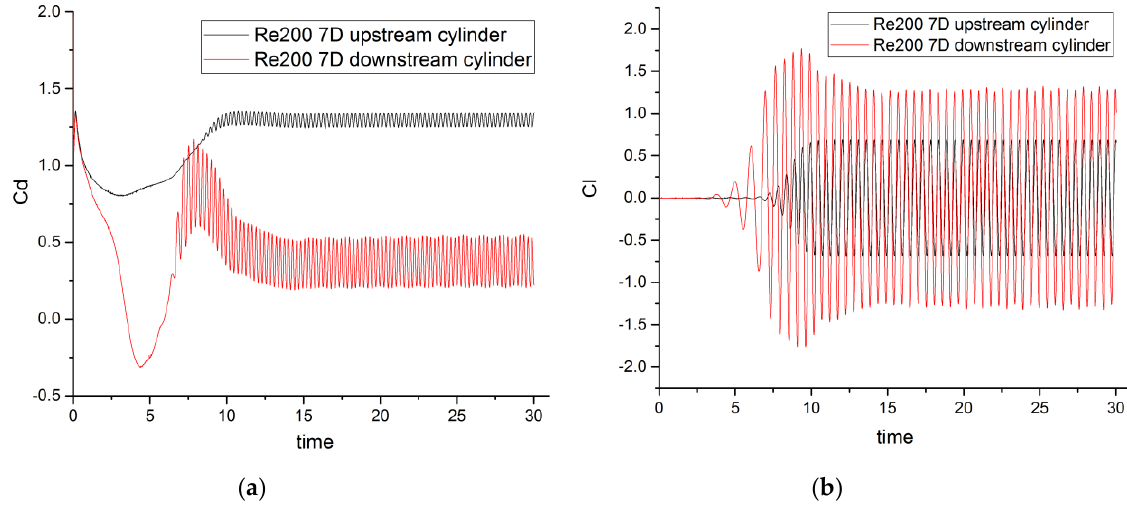
Figure 14. The history of drag and lift coefficients for Re = 200, L/D = 7: ( a ) drag coefficient; ( b ) lift coefficient.